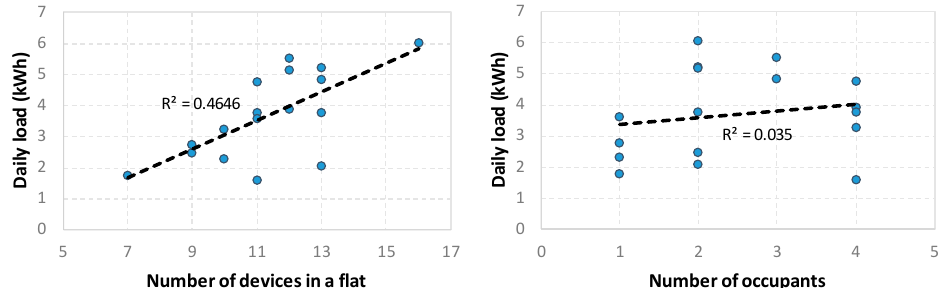
Figure 2. Daily electricity variations according to the number of appliances ( left ) and to the number of occupants ( right ).